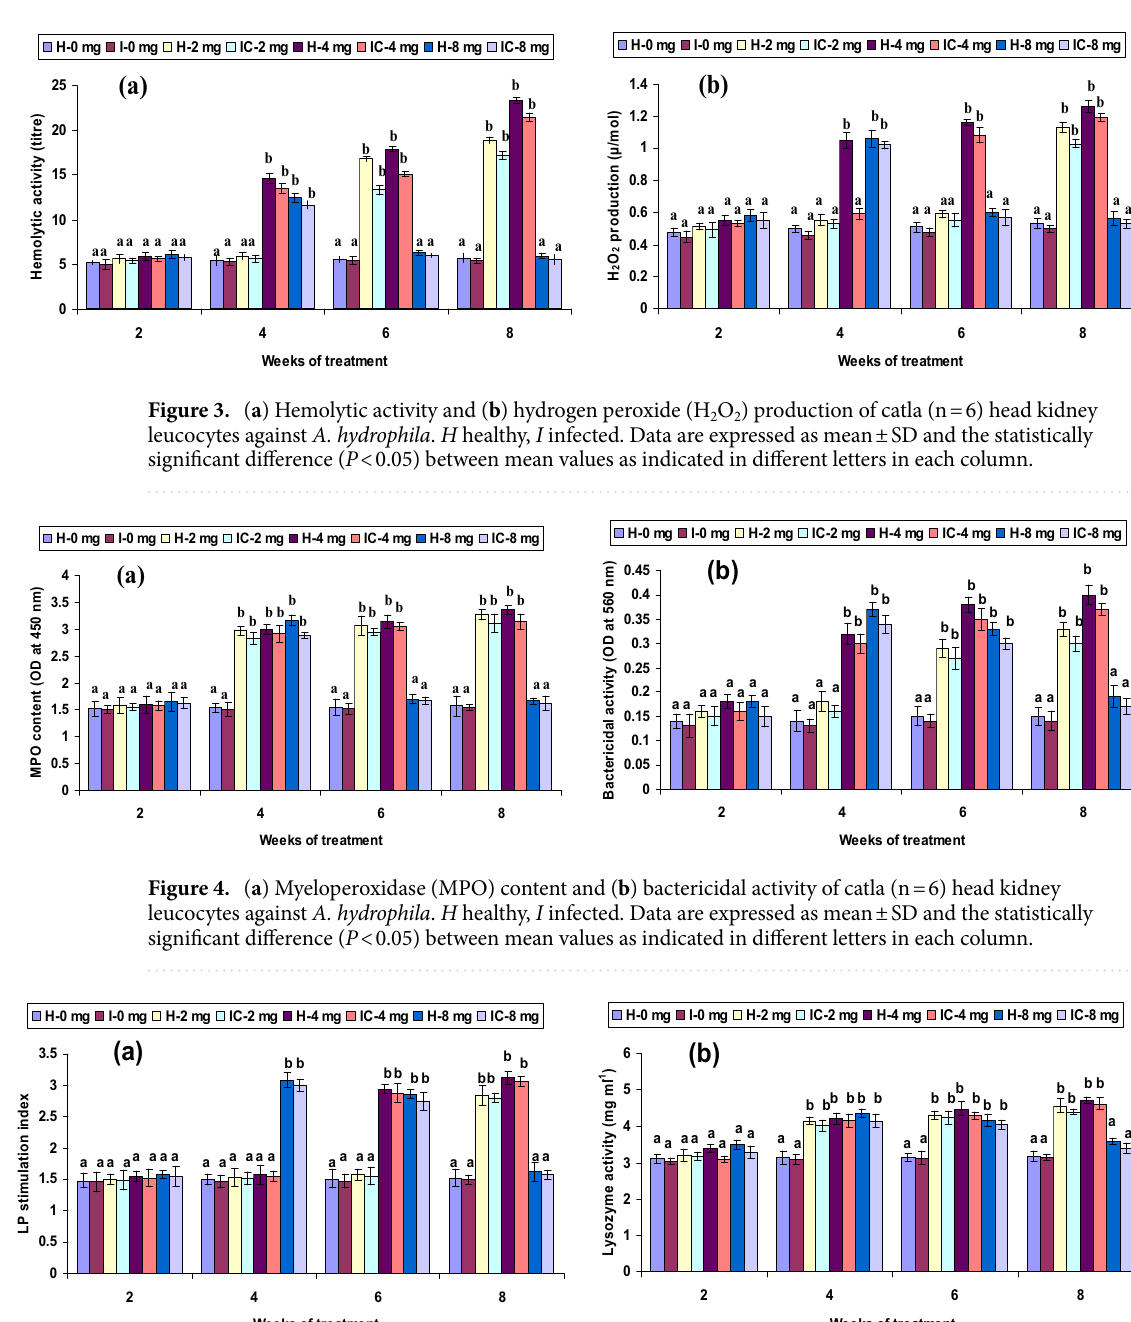
(Fig. 1b). The nitric oxide (NO) synthase was low in both 2 CA groups (weeks 2–6); increased significantly after the 8th week. Similarly, both 4 CA groups had slightly higher levels ( P > 0.05) of NO synthase in the 2nd and 4th weeks, and significantly ( P < 0.05) higher levels between weeks 6 and 8. NO synthase levels varied moderately ( P > 0.05), except in week 2 (Fig. 2b).